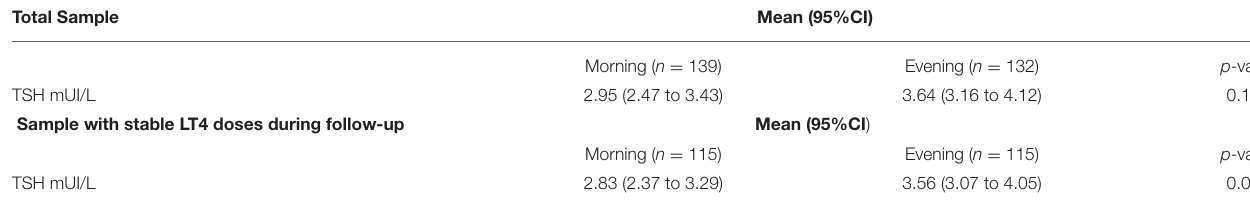
TABLE 2 | Effects of bedtime vs. morning levothyroxine intake in Thyroid-Stimulating Hormone (TSH) levels (crossover model).